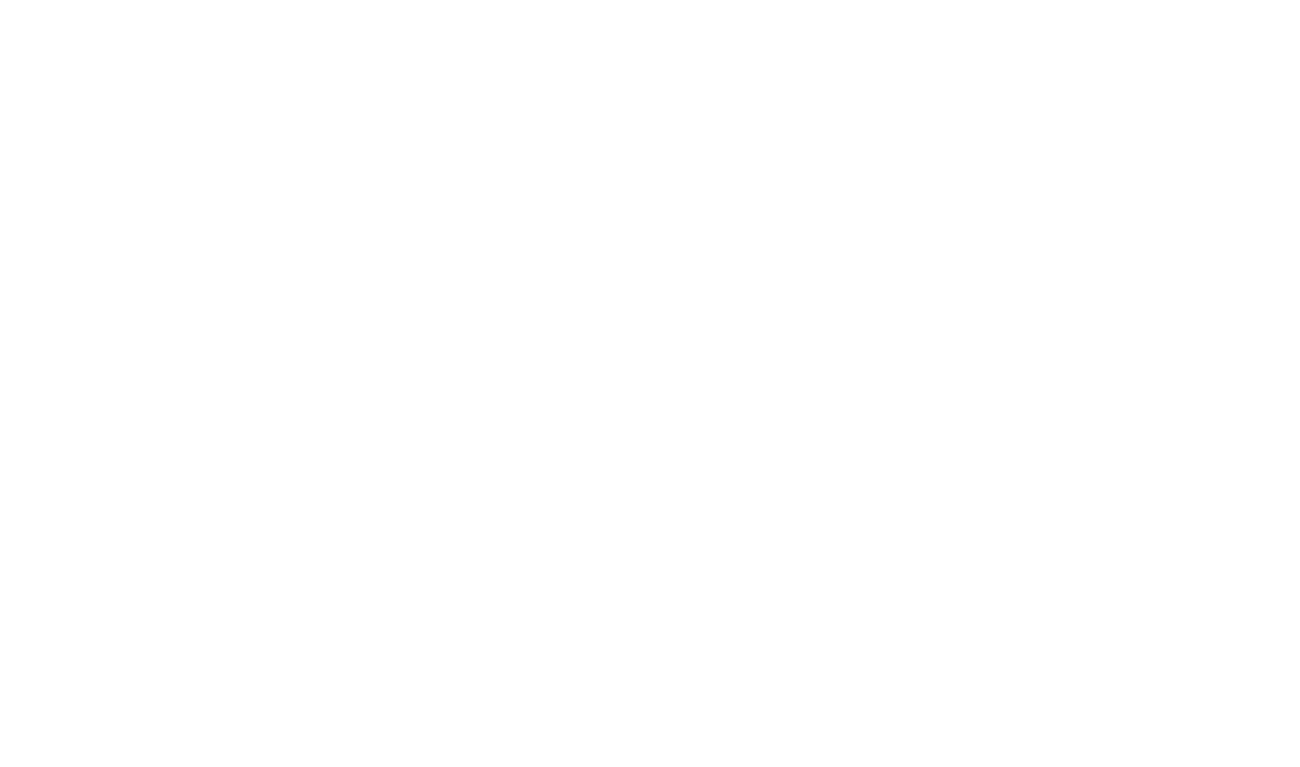
Frontiers in Pharmacology |